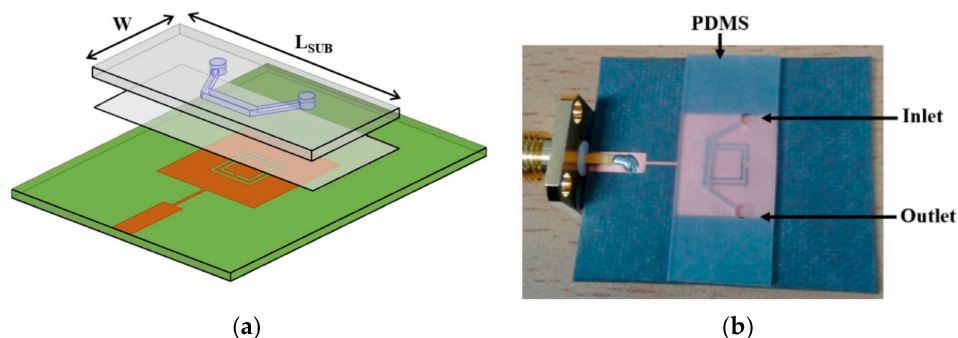
Figure 8. The view of the Rogers substrate (green area) with the polydimethylsiloxane (PDMS) microchannel ( a ) and the photo of the fabricated microfluidic-microwave device ( b )